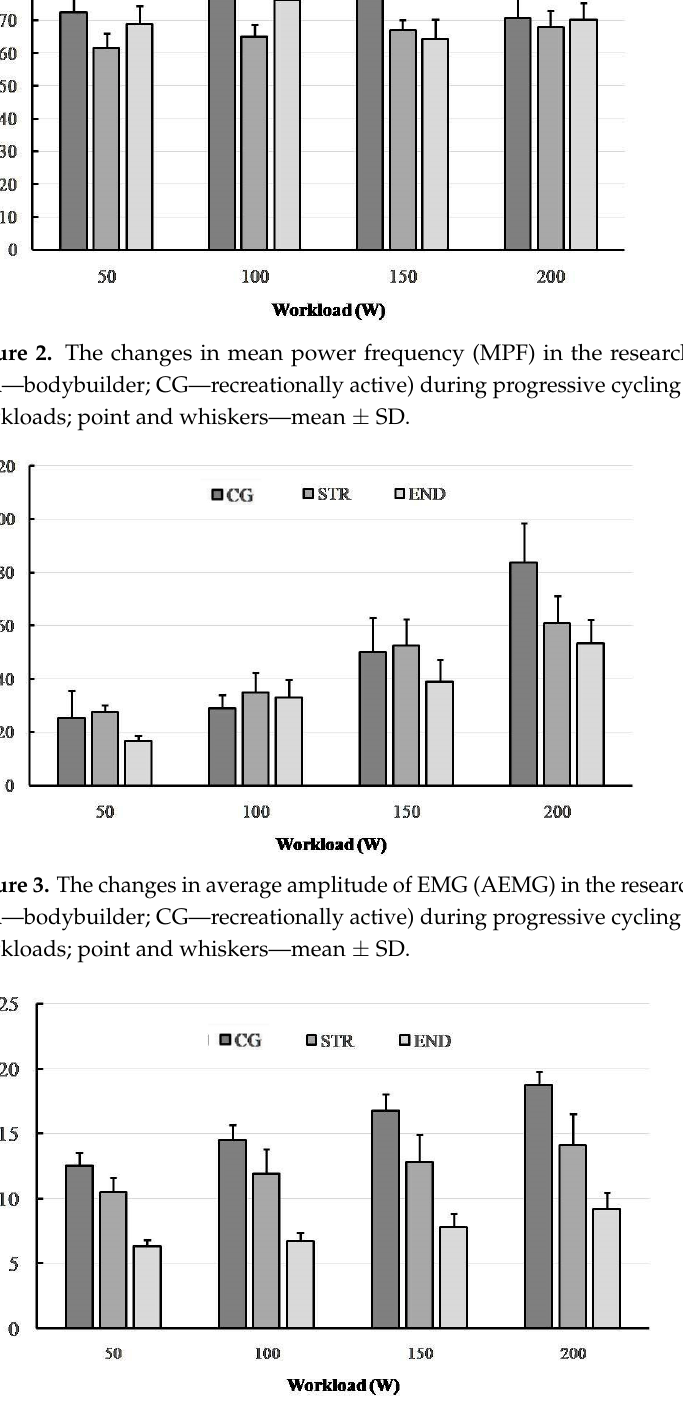
Figure 4. The changes in ratings of perceived exertion (RPE) in the research groups (END—triathlon; STR—bodybuilder; CG—recreationally active) during progressive cycling exercise test at subsequent workloads; point and whiskers—mean ± SD.